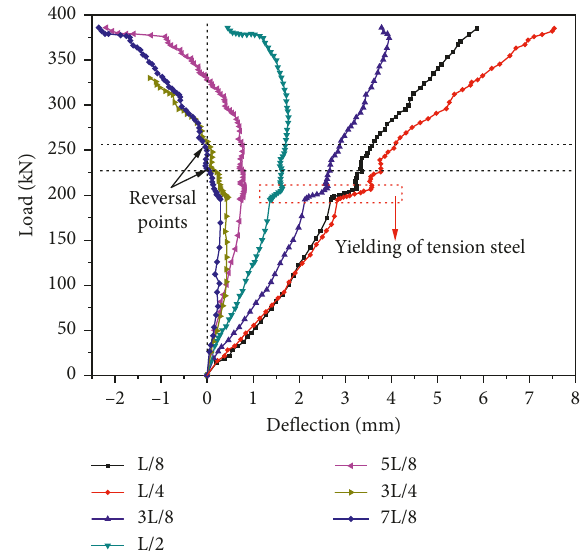
Figure 7: Load-deflection results of key points.